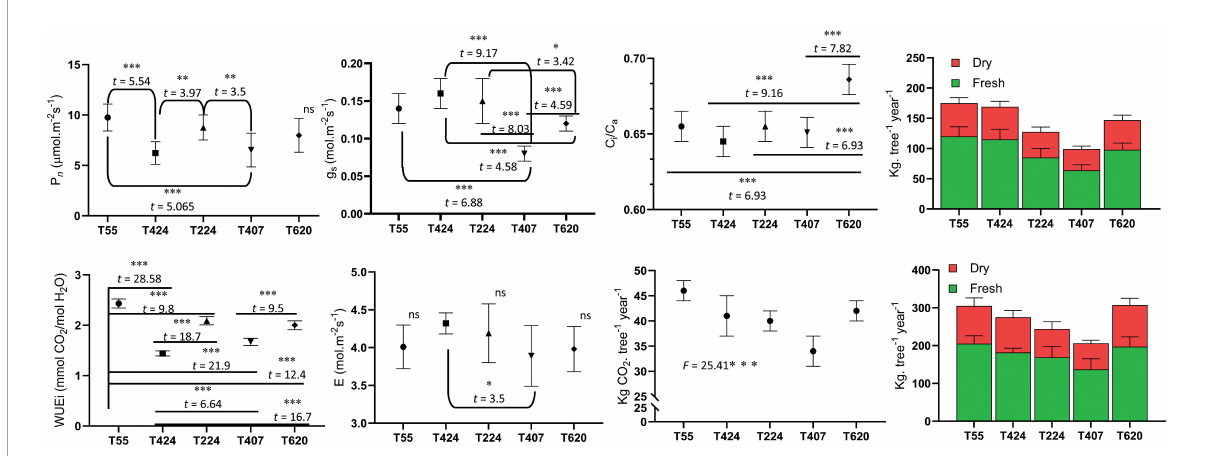
FIGURE2 Leaf gas exchange parameters of different accessions of pongamia along with above and belowground tissues biomass and amount of CO 2 sequestered per plant. Data are the mean ± SD. The difference between variables of individual accessions was indicated with t and F statistic at ∗ p = 0.1, ∗∗ p = 0.05, and ∗∗∗ p = 0.01 level of